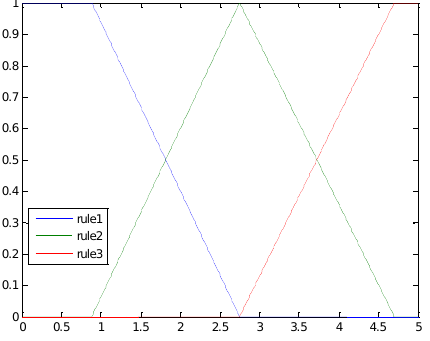
Figure 2. Membership function.